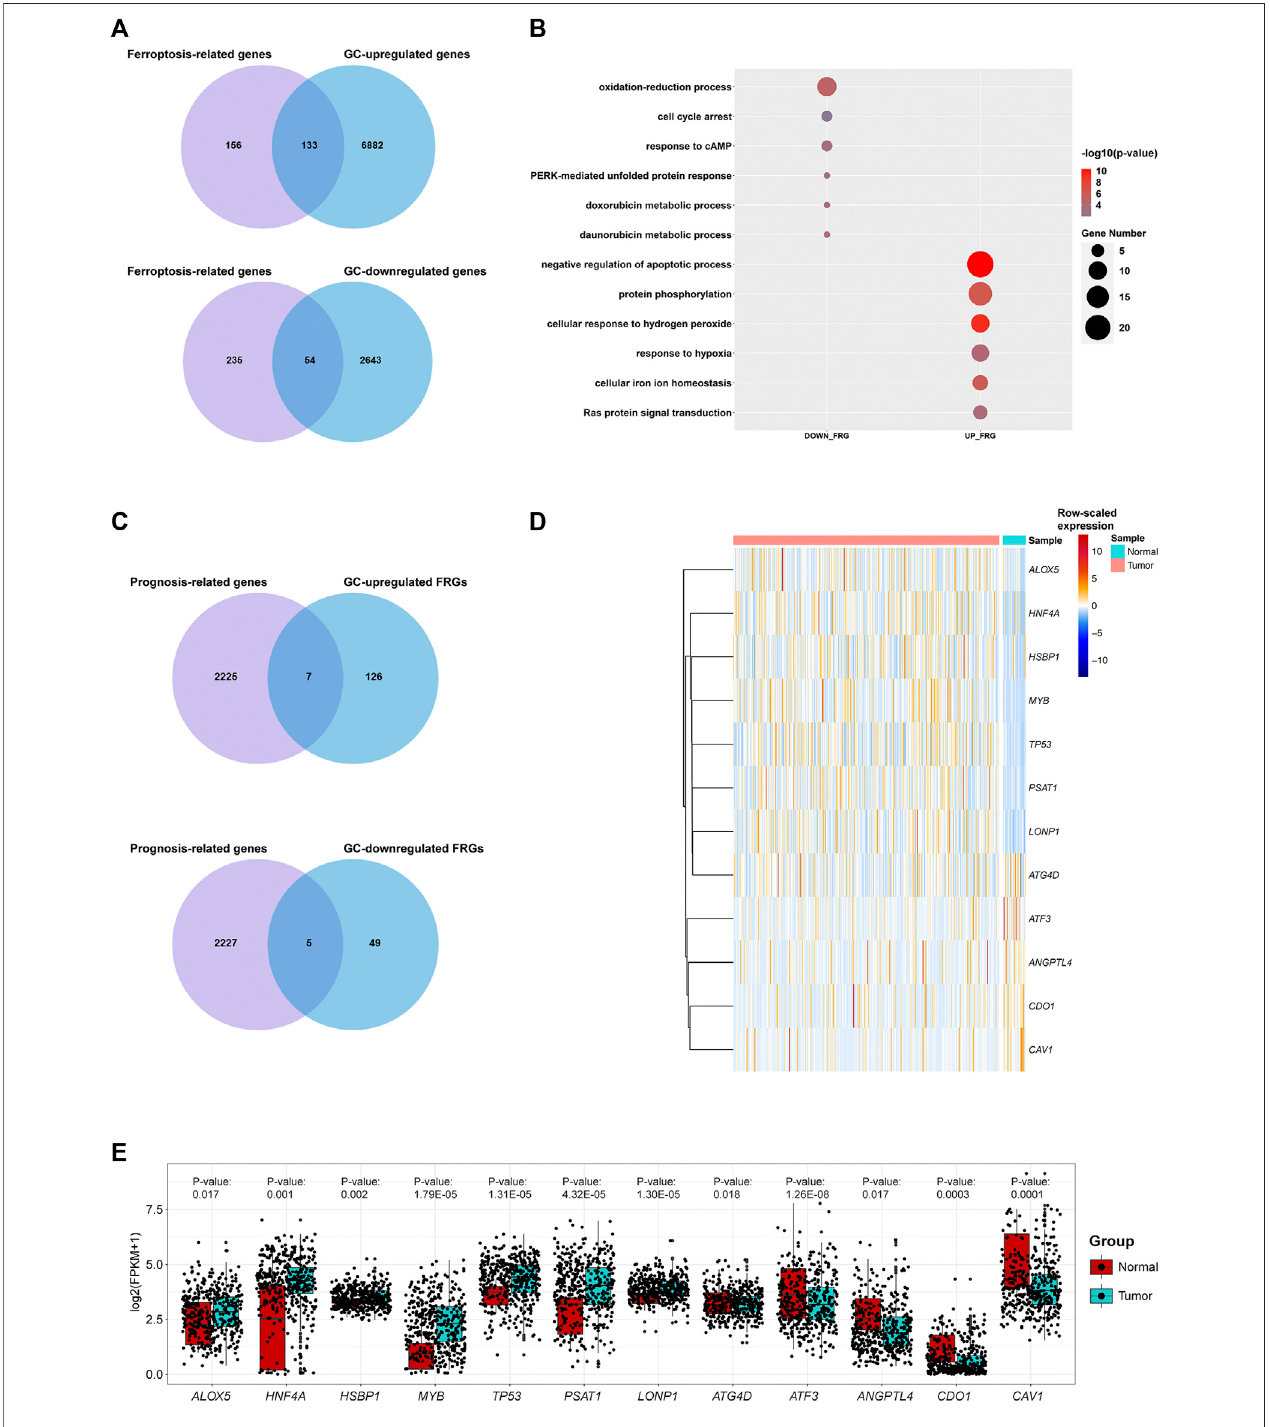
FIGURE 2 | Transcriptome pro fi ling of gastric cancer samples in the TCGA dataset. (A) Venn diagram representation of ferroptosis-related genes (FRGs) and differentially expressed genes (DEGs) between GC samples and adjacent cancer samples in the TCGA dataset. (B) Representative GO terms of GC-differentially expressed FRGs in the TCGA dataset. (C) Venn diagram representation of prognosis-related genes and GC-differentially expressed FRGs in the TCGA dataset. (D) Heatmap plot for raw-scaled expression of important FRGs in GC samples and adjacent cancer samples in the TCGA dataset. (E) Boxplot for the expression (log(FPKM+1)) of the 12 differentially expressed FRGs.